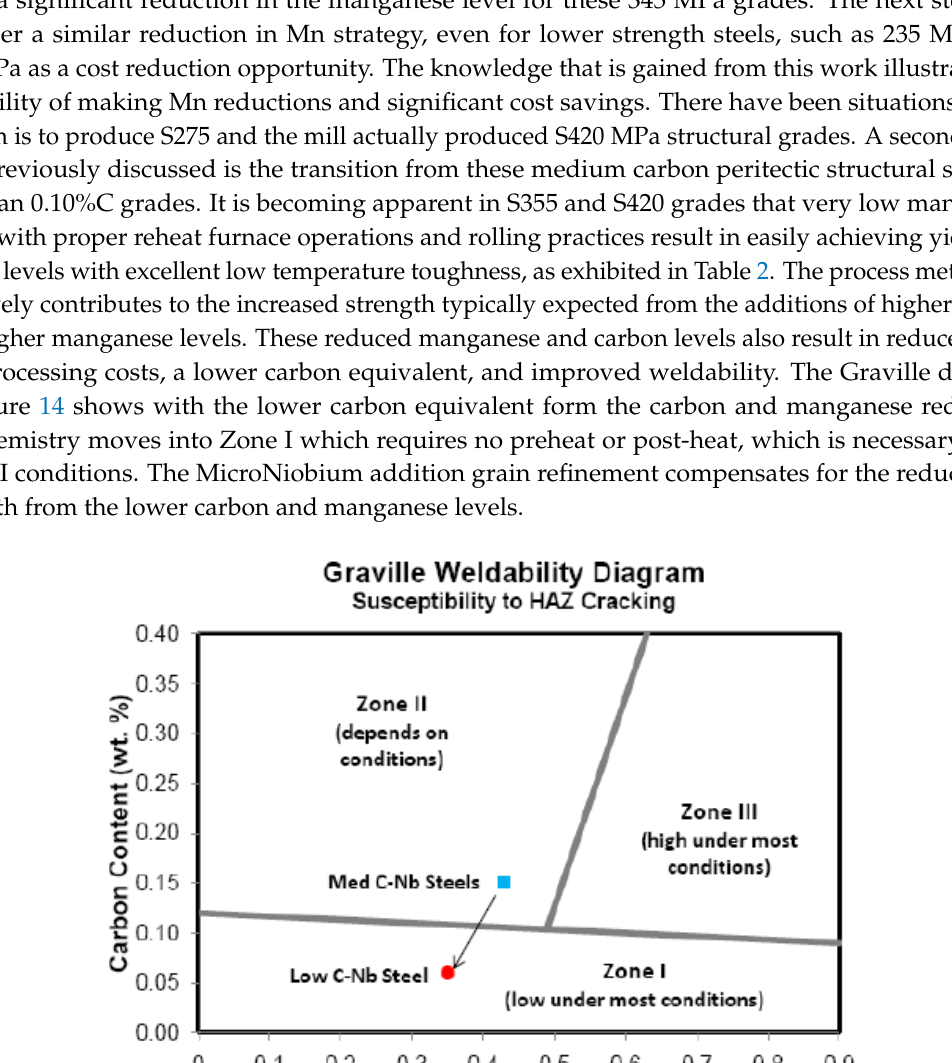
Table 2. Peritectic (0.16%) low Mn-MicroNb mechanical properties *.